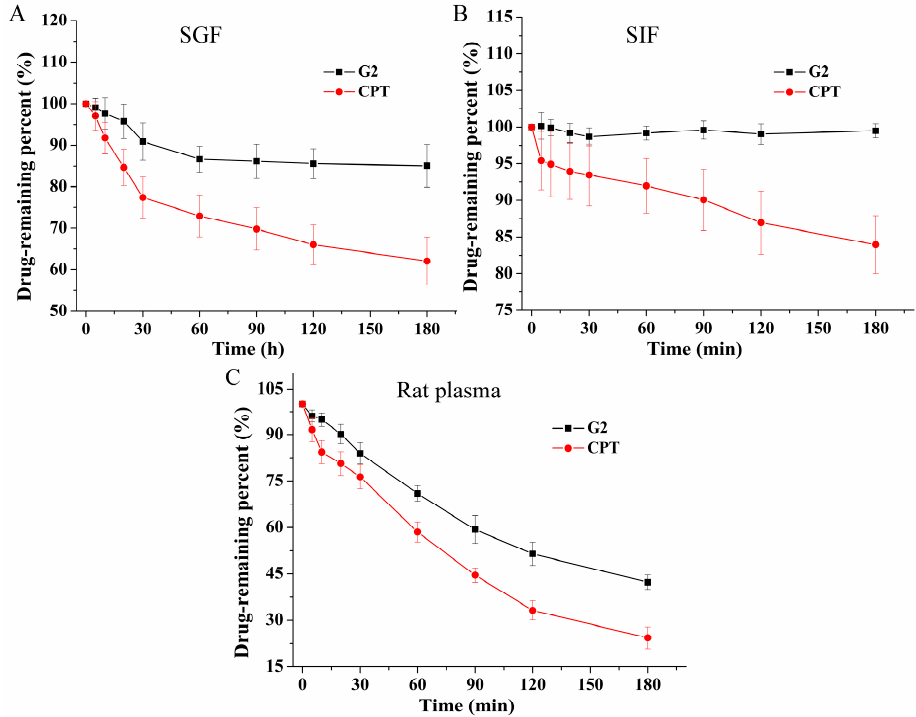
Figure 5. Stability of G2 and CPT was studied in ( A ) simulated gastric fluid (SGF), ( B ) simulated intestinal fluid (SIF) and ( C ) fresh rat plasma.